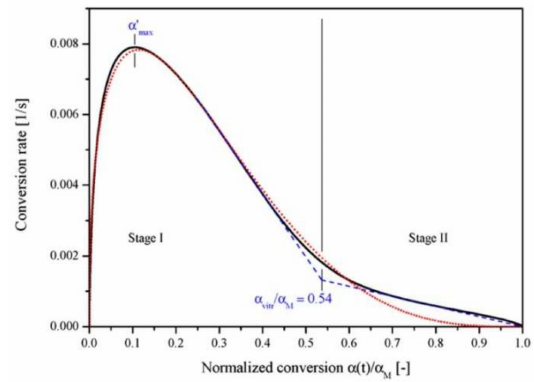
Figure 25. Comparison of experimental photo-DSC (black line) and modeled (red line) conversion rates versus normalized conversion of a cycloaliphatic epoxy compound at 30 ◦ C and a light intensity of 50 mW cm − 2 . Reprinted from reference [150] with permission of